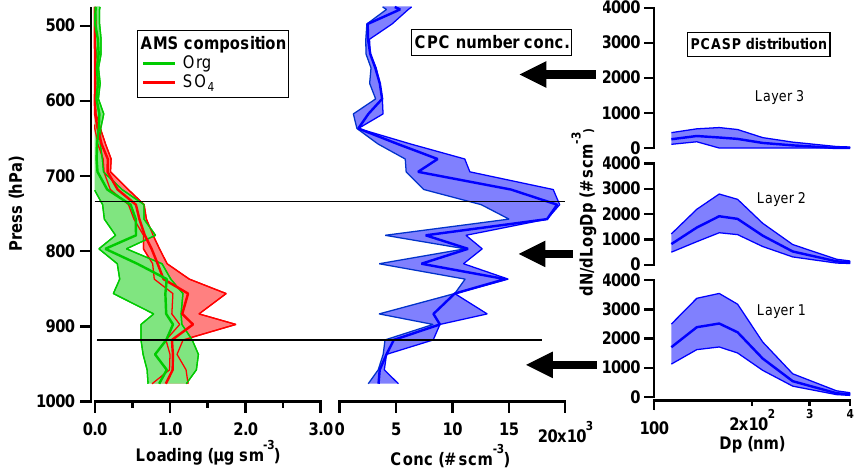
Fig. 8. Average altitude profiles (median and interquartile ranges) during the afternoons of the ITC-dominated regime over East Sabah of organic and sulphate aerosol loading, number concentration and number/size distribution for each layer. Averages comprise three profiles on 11 July 2008.